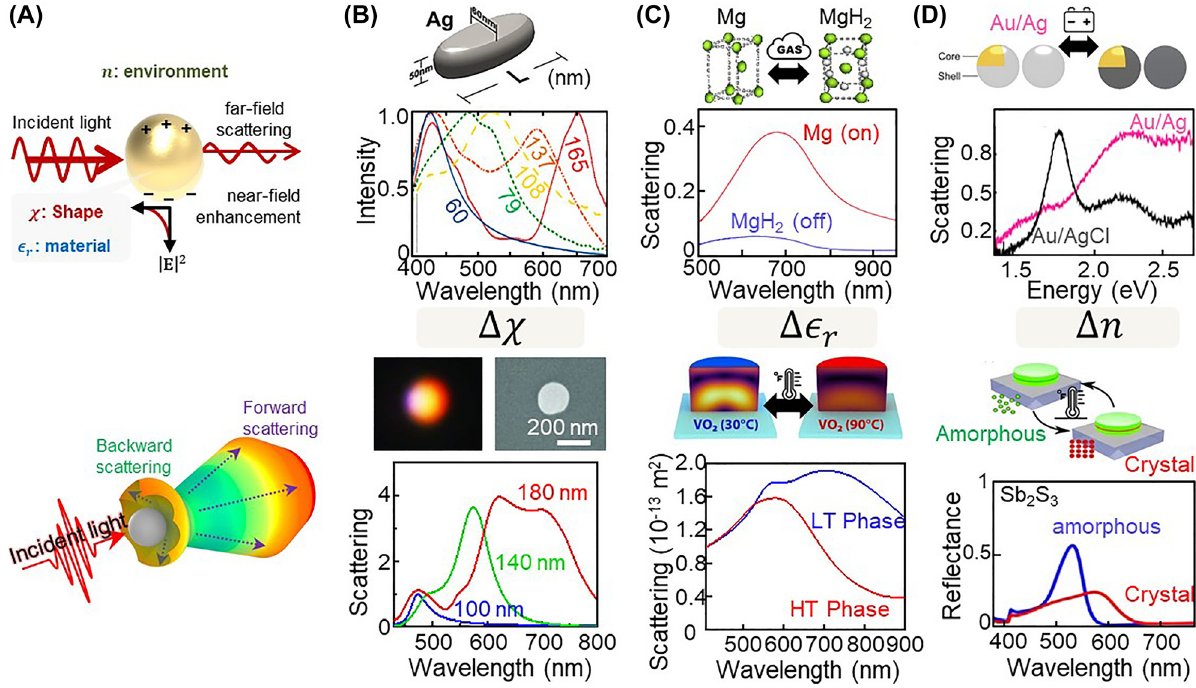
Figure2: Plasmonic(toppanel)andMie(bottompanel)resonances:(A)associatedschematicsoftheopticalinteractionsandcolorationsdue to changes in the nanoparticle ’ s (B) shape and size (reproduced with permission [19, 77]. Copyright 2016, American Association for the Advancement of Science and 2014, Europe PMC), (C) material composition (reproduced with permission [78 – 80], Copyright 2018, American Association for the Advancement of Science, 2009, Elsevier B.V., and 2021, American Chemical Society), and (D) surrounding optical environment (reproduced with permission [81, 82]. Copyright 2015, American Association for the Advancement of Science, and 2020, Optica Publishing